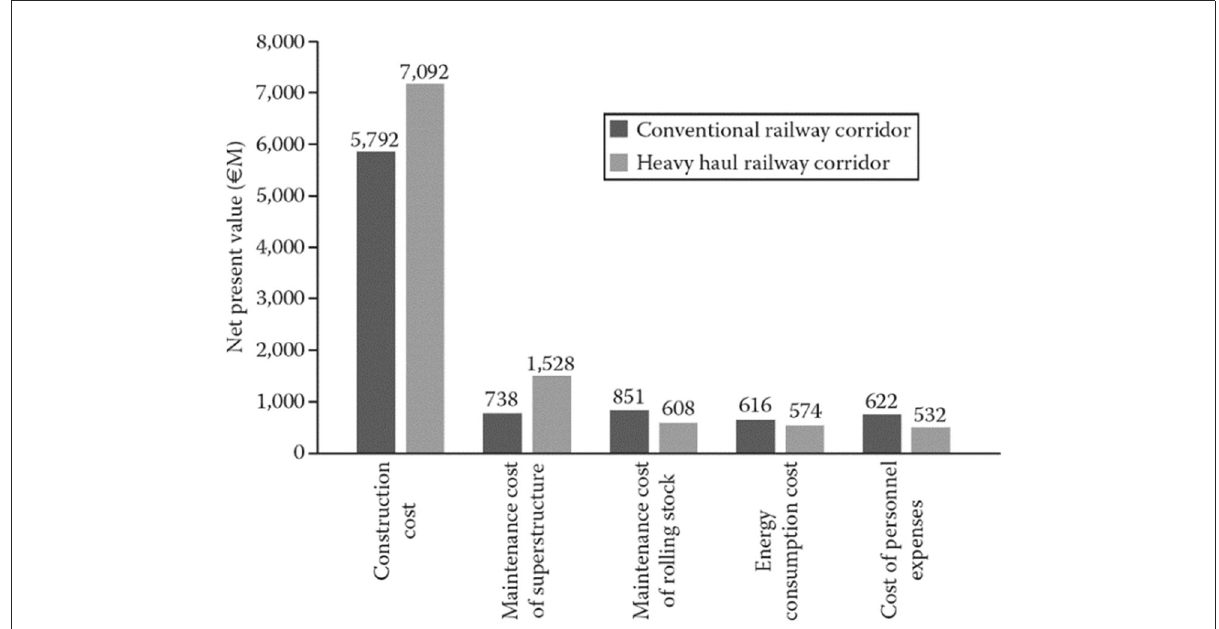
FIGURE5 Construction, maintenance, and operational costs for conventional and heavy axle-load lines – length of connection S = 1,000km, demand for freight = 30,000t per day per direction (Pyrgidis and Christogiannis,